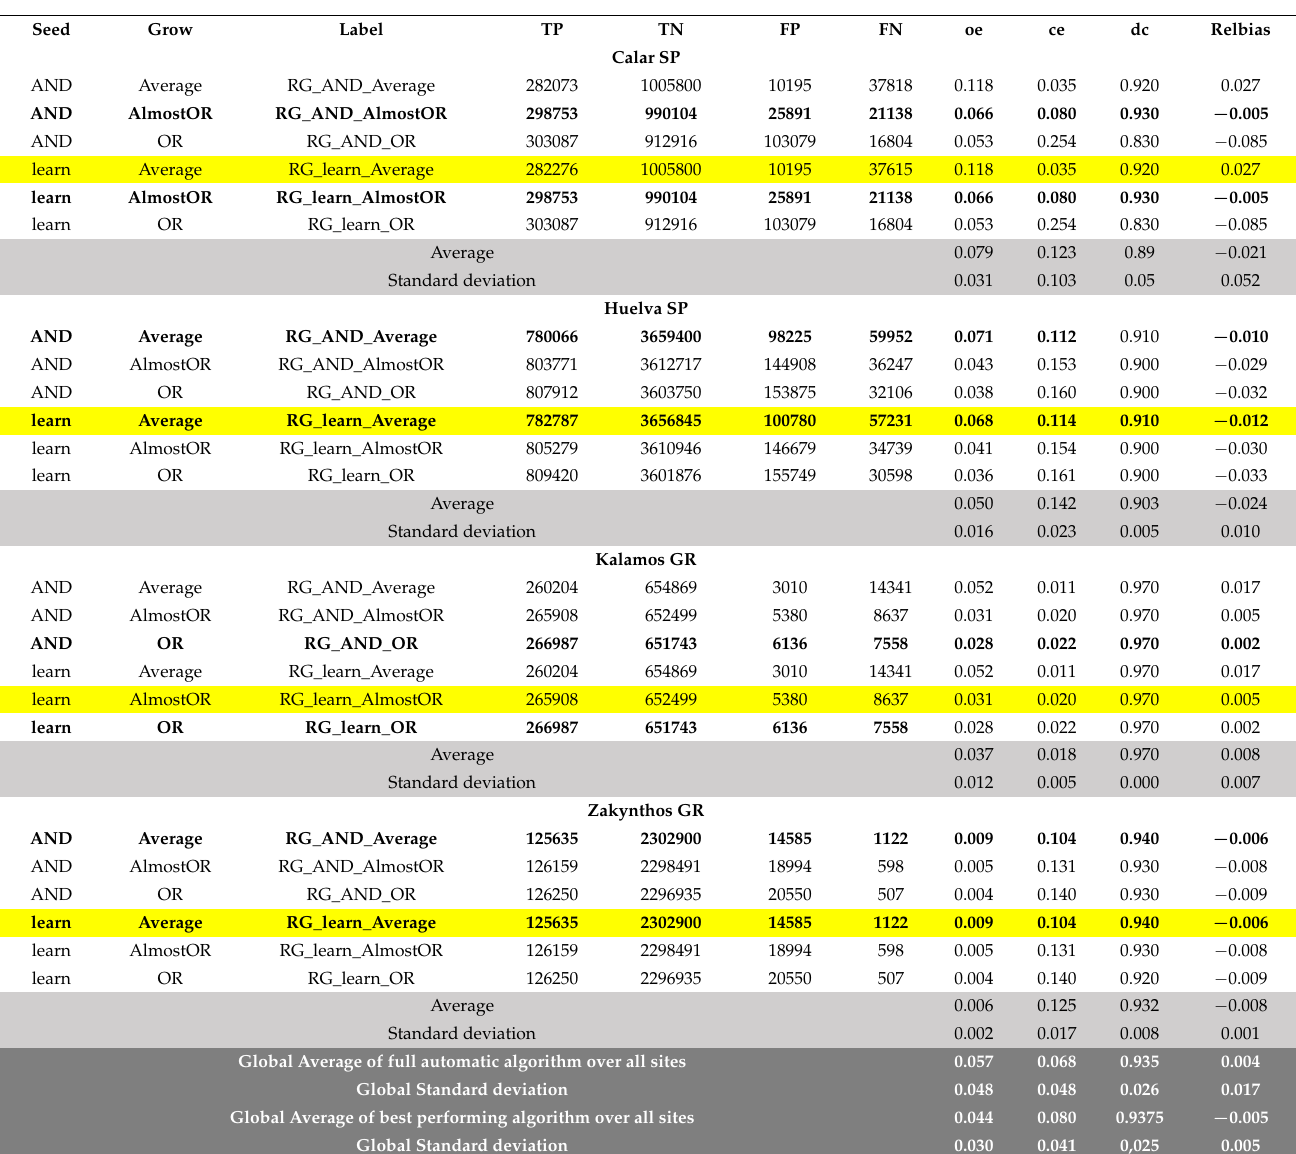
Table A1. Confusion matrices (TP = true positive, TN = true negative, FP = false positive, FN = false negative) and the metrics (omission error = oe, commission error = ce, Dice coefficient = dc, relative bias = relbias) for the selected and tested combinations of OWAseed and OWAgrow in the RG algorithm. Labels are the same displayed in Figure 5. The lines in bold are the best performing combinations of the seed and grow layer in each site; the lines outlined in yellow are those corresponding with the full automatic